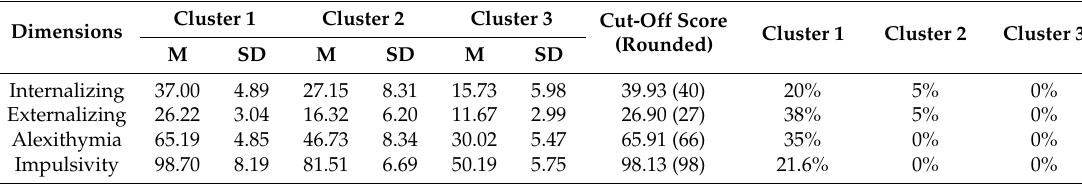
Table 2. Percentages of individuals with clinically relevant binge eating behaviors as for each cluster.